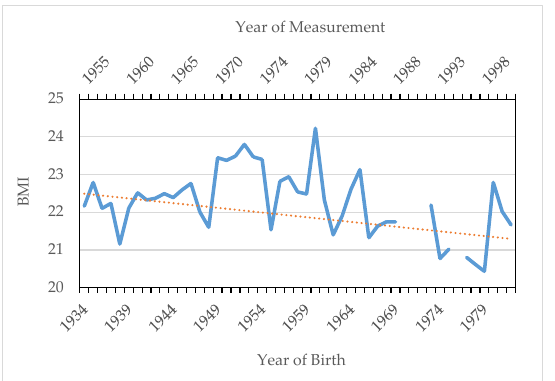
Figure 7. Annual average BMI (1955 – 2001) in SB. Trend line. Source: AMSB, ACDS. Own work.